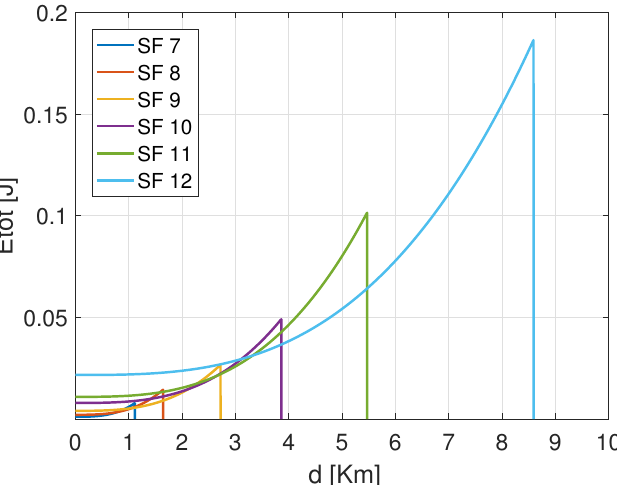
Figure 4. Total consumed energy versus distance d using SF 7 with CR 4/7 to carry out 30 Bytes payload.